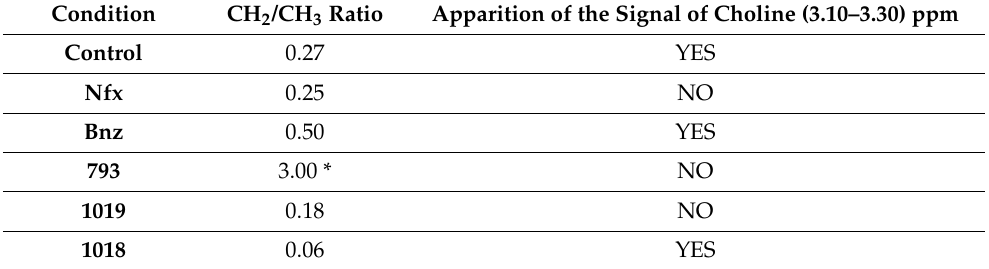
Table 3. Changes in the 1 H-NMR experiments, integration ratios of CH 2 /CH 3 and choline signal, for the different treatments of T. cruzi with studied compounds and the control (untreated